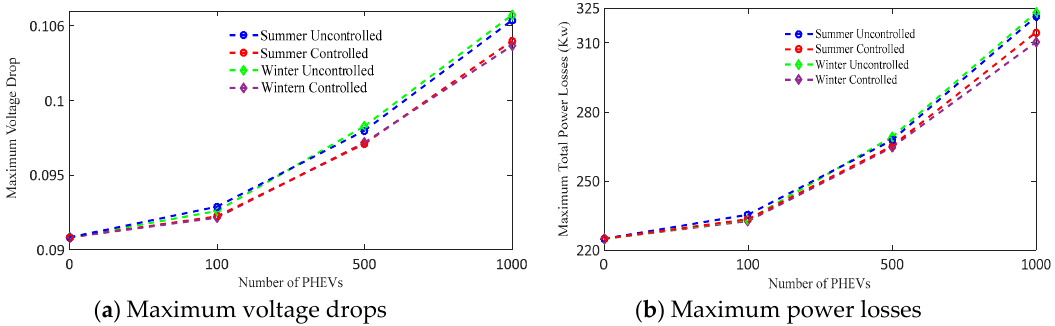
Figure 10. ( a ) Maximum voltage and ( b ) Maximum total power losses for controlled and uncontrolled charging using deterministic approach.